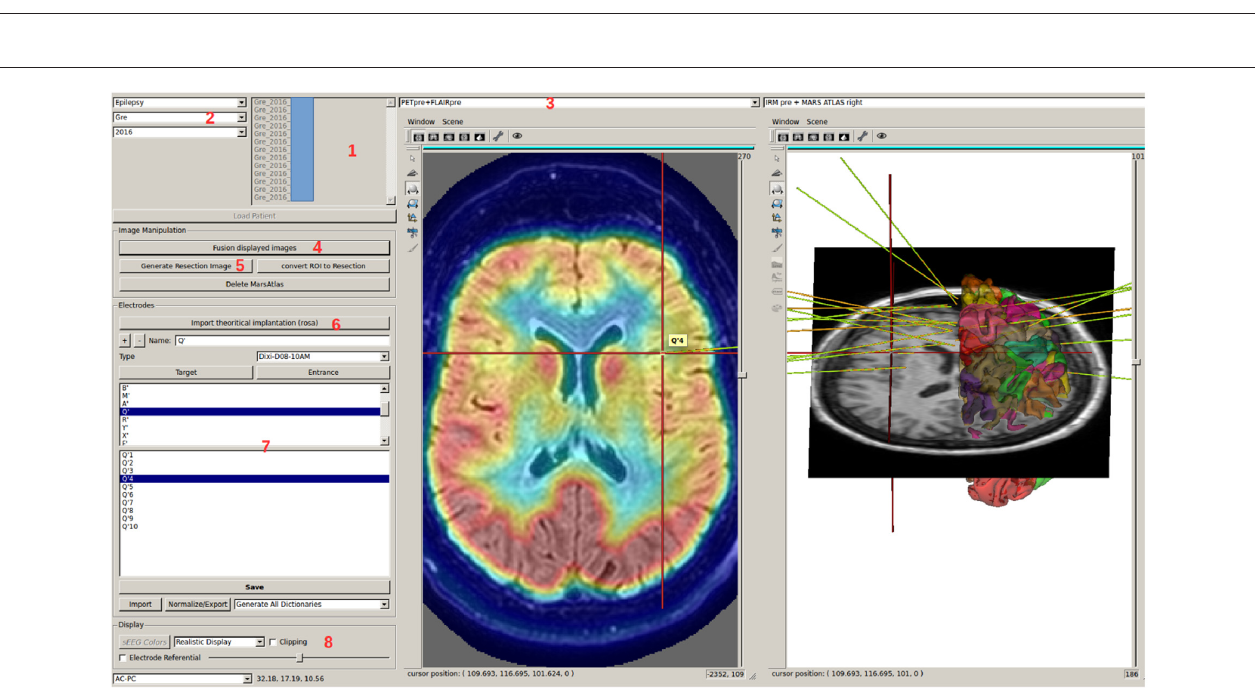
FIGURE 4 | LocateElectrodes interface allows to select a patient in the database (1), using searching criteria (2). The user can navigate in the different imported images using (3), fusion them easily (4), generate the resection mask (5) if the T1 post-resection was imported. Using (6), the user can add, position and name electrodes after choosing a predefined 3D model. Clicking on electrode/contact names (7) updates the 3D Anatomist viewers on the right (here on contact Q’4), and the red 3D cursor moves to the contact. The view can be axial/sagittal/coronal, or in the electrode referential using (8). Here, Positron Emission Tomography (PET) and T1 MRI fusion are displayed on the left, MarsAtlas cortical parcellation and T1 MRI on the right with the implanted electrode models.